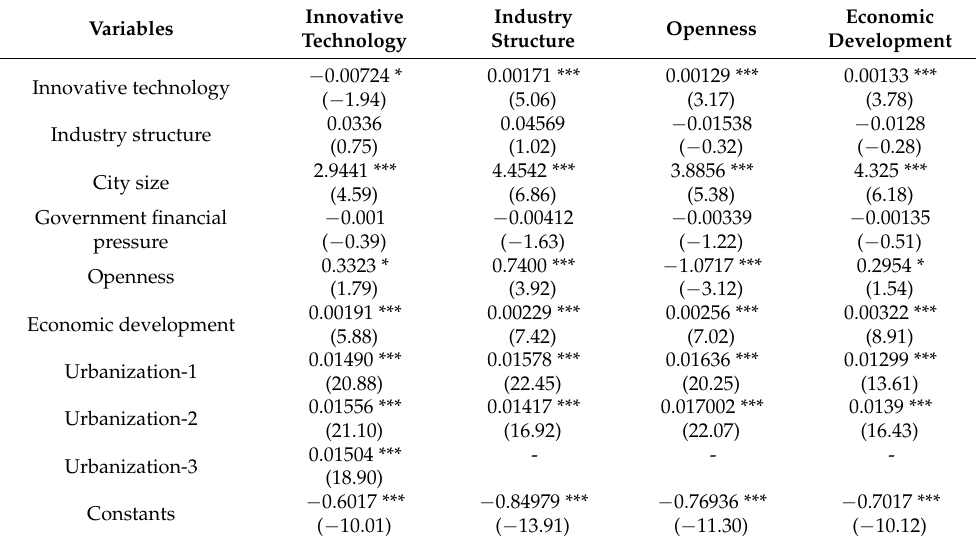
Table 7. Regression results for the threshold effect of each